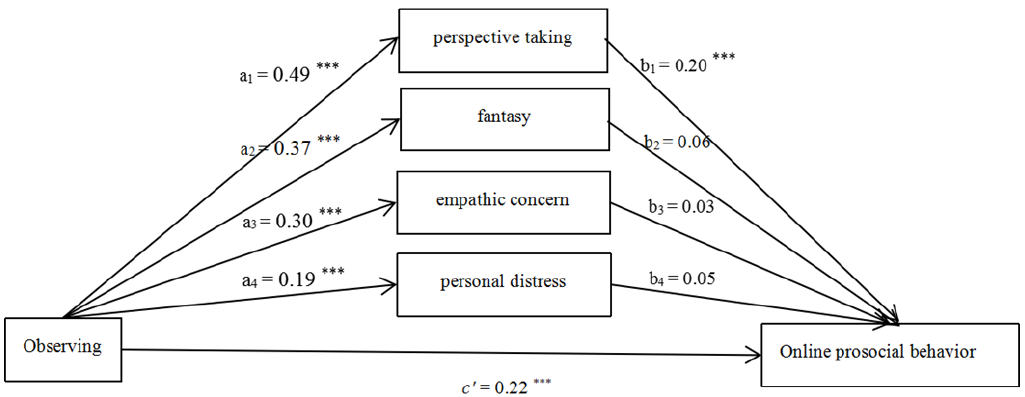
Figure 1. Mediating roles of empathy components (Observing as the predictor). Note: *** p < 0.001.